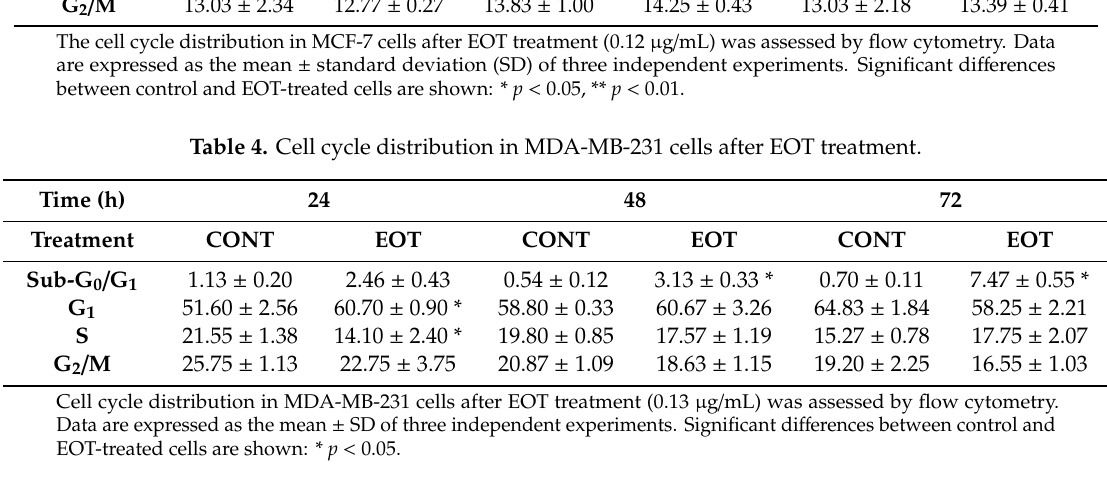
Table 5. Induction of apoptosis in MCF-7 cells after EOT treatment.